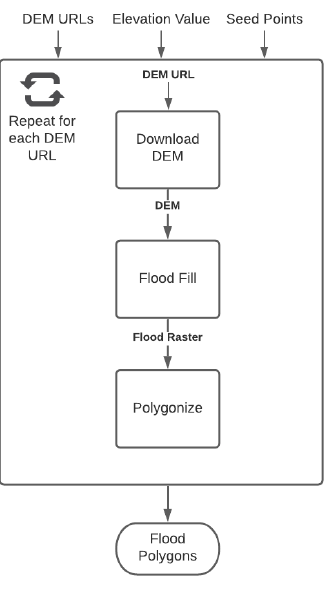
Figure 17. Visual representation of the flood inundation prediction workflow.